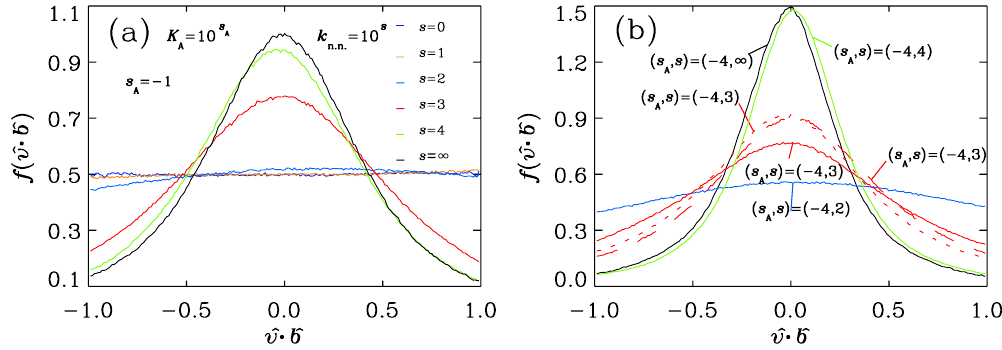
Figure 2. Distribution functions f for the direction cosine ⋅ ˆ ˆ v b between the velocity direction ˆ v of a monomer and its bond direction ˆ b along a polymer chain in systems described in Fig. 1: ( a ) with the same strength of angle potential, s A = − 1 (dashed red vertical line on the right side of Fig. 1(e)) and with different stiffness s = 0, 1, 2, 3, 4 51 and ∞ ref. 52, respectively, undergoing no aggregation; ( b ) with ( s A , s ) = ( − 4, 2), ( − 4, 3), ( − 4, 4) (in this study, dashed red vertical line on the left side of Fig. 1(e)) and ( − 4, ∞ ) 48 , which undergo aggregation processes without external controlling on temperatures. Each of the distributions is obtained by collecting data of 2000 snapshots, in intervals of 5 steps, over a quasi-steady situation. of period 0.25 τ in time step δ t = 2.5 × 10 − 5 τ (see Methods ). In plot (b), we include three curves for the distributions of the system with ( s A , s ) = ( − 4, 3) (collected over time intervals at t = 293.5 (red dashed line), t = 353.5 (red broken line) and t = 822.5 (red solid line), respectively, in Fig. 6). The corresponding values for q can be found in Fig. 4 (for plot (a)) or Fig. 5 (for plots